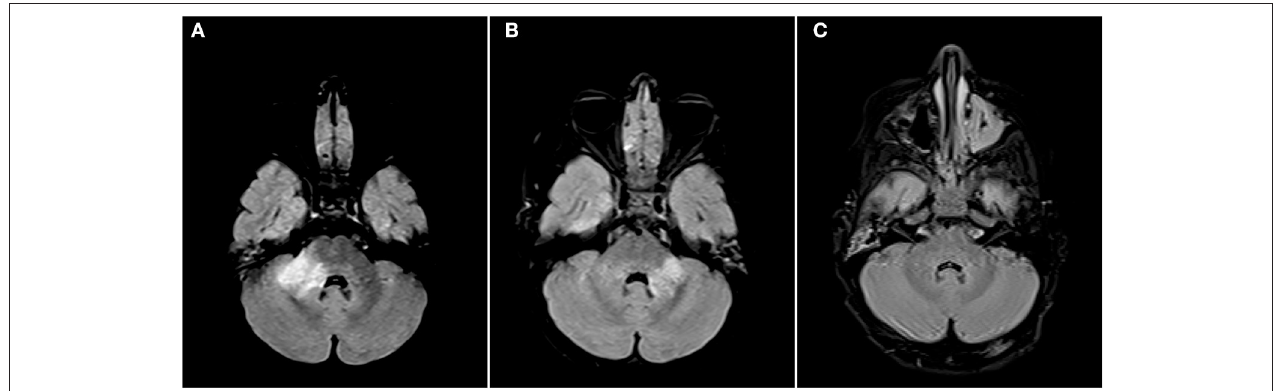
FIGURE 2 | Axial FLAIR images of the brain from the same patient across serial examinations. (A) At the time of disease presentation: a FLAIR hyperintense lesion involves the right middle cerebellar peduncle. (B) Approximately 2 months later: the lesion in the right middle cerebellar peduncle has nearly completely resolved and there has been interval development of a new lesion in left middle cerebellar peduncle. (C) More than 1 year later: The posterior fossa lesions as well as other supratentorial lesions (not shown) have completely resolved.